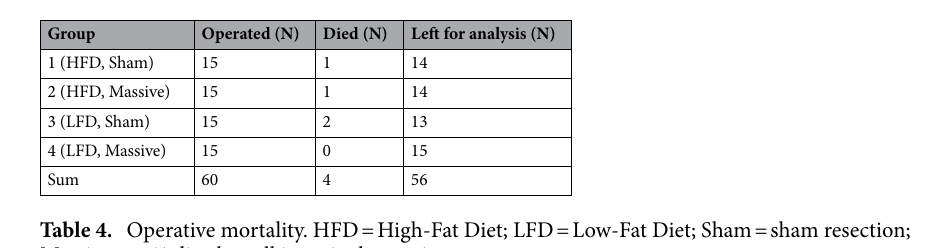
Table 4. Operative mortality. HFD = High-Fat Diet; LFD = Low-Fat Diet; Sham = sham resection; Massive = 75% distal small intestinal resection.